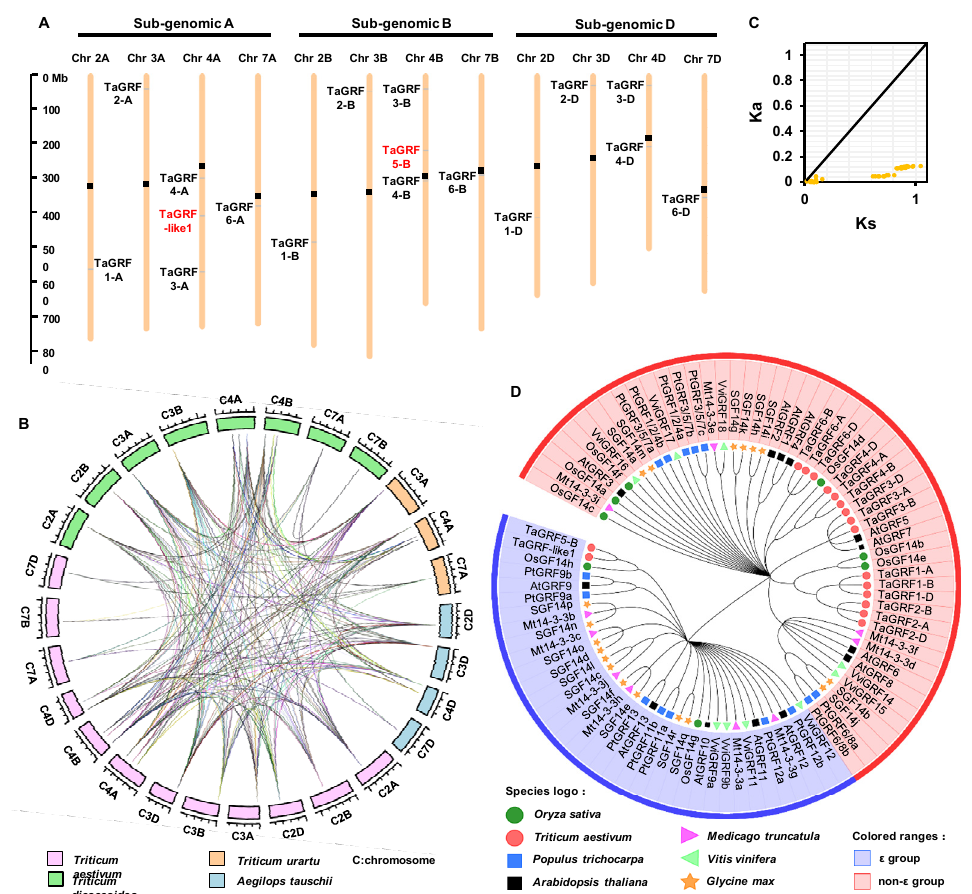
Figure 2. Evolutionary analysis of TaGRFs ( A ) Chromosomal locations and repeated events of TaGRFs. Orange bars represent chromosomes. The black rectangular dots above is the centromere. The scale indicates the corresponding physical distance. Chr 2A is the second chromosome on sub-genome A. The ε group genes are shown in red font, and non- ε group genes are shown in black font. The segmentally duplicated homologous genes were marked with blue lines. ( B ) Orthologous relationships analysis among T. aestivum (Ta, AABBDD, pink box) and progenitor species Ae. tauschii (Ae, DD, blue box), T. urartu (Tu, AA, orange box), and T. dicoccoides (Td, AABB, green box). The lines represent collinearity between chromosomes. ( C ) Ka/Ks value of TaGRF repeat gene pair. ( D ) Phylogenetic analysis of TaGRF proteins and other species such as A. thaliana, O. sativa, G. max, P. trichocarpa, M. truncatula, and V. vinifera. ClustalW2 was used to align the protein sequences, and the phylogenetic tree was constructed by the Neighbor-Joining (NJ) method of MEGA 7 with 1000 bootstrap replicates. Then the tree was modified by ITOL online tool. The two major groups were marked with different colors.